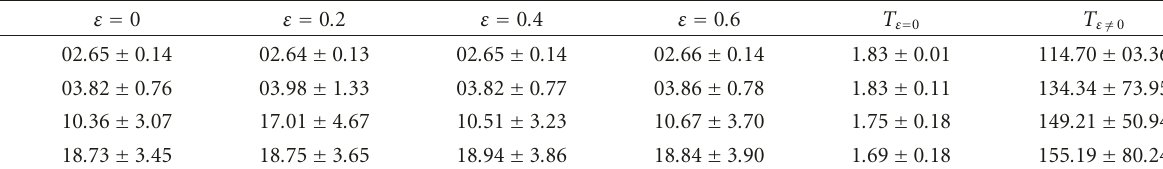
Table 1: Reconstruction error (NPMSE, %) and computation time ( T ε , s ) for di ff erent kernel factors ( ε ) and di ff erent signal to noise ratios represent the computation time without and with the calculation of the second term of (3), respectively. (SNR, dB). T ε = 0 and T ε / = 0